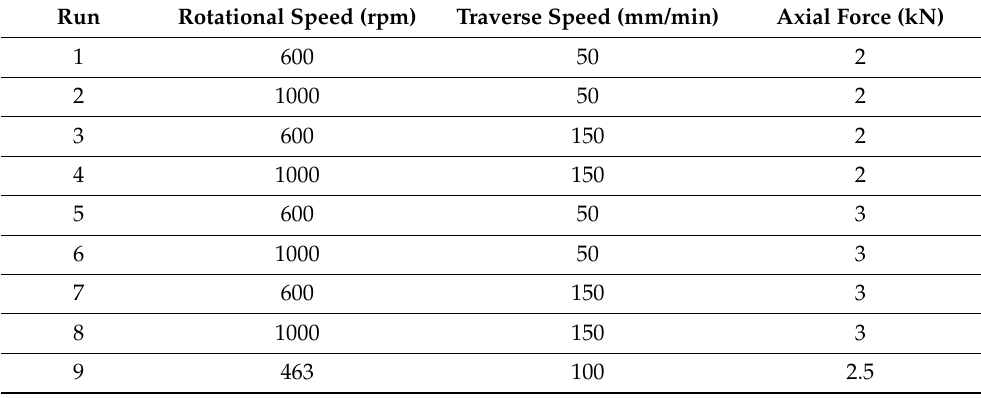
Table 2. Experimental design matrix used in this